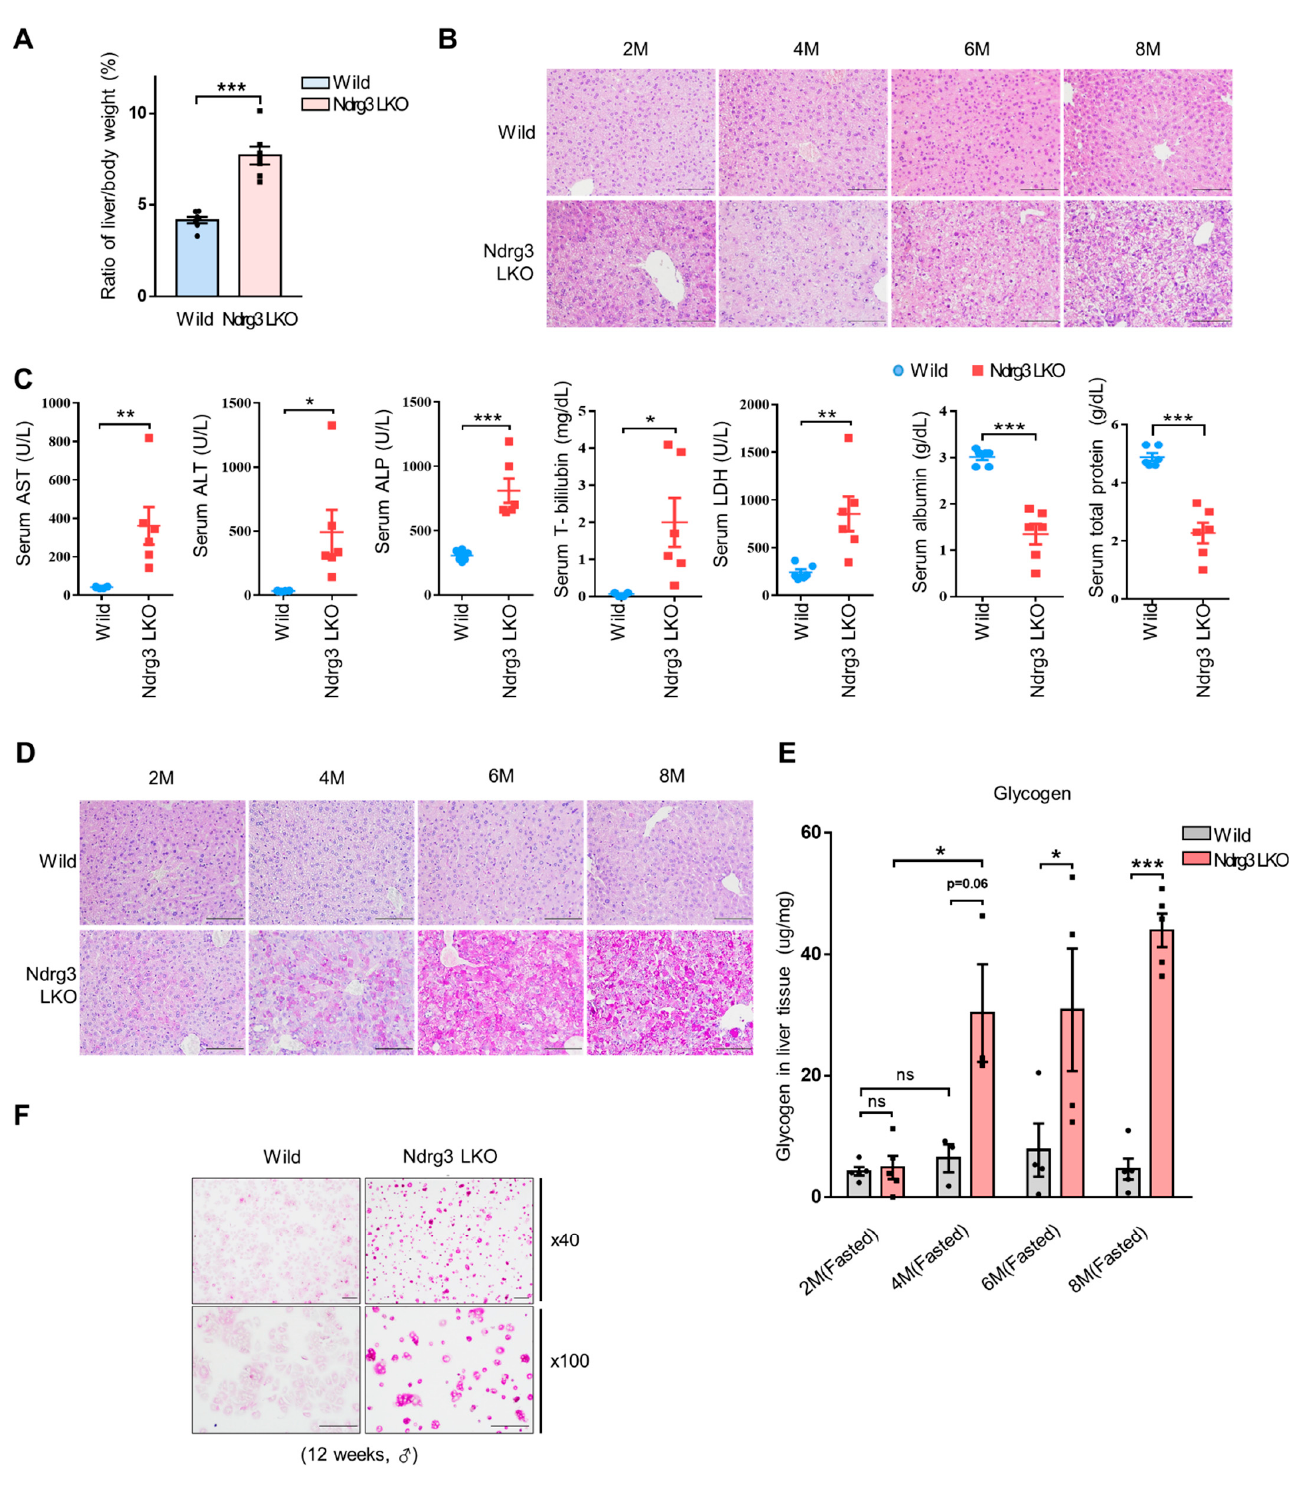
Figure 1. Pathologic changes and abnormal glycogen accumulation in NDRG3-depleted mouse livers. ( A ) Liver-to-body weight ratios of wild-type and Ndrg3 LKO mice at the age of 8–12 weeks ( n = 7 per group). ( B ) Hematoxylin and eosin stained liver tissues of wild-type and Ndrg3 LKO mice at increasing ages. Scale bars; 100 µ m. ( C ) Quantification of liver functional parameters analyzed